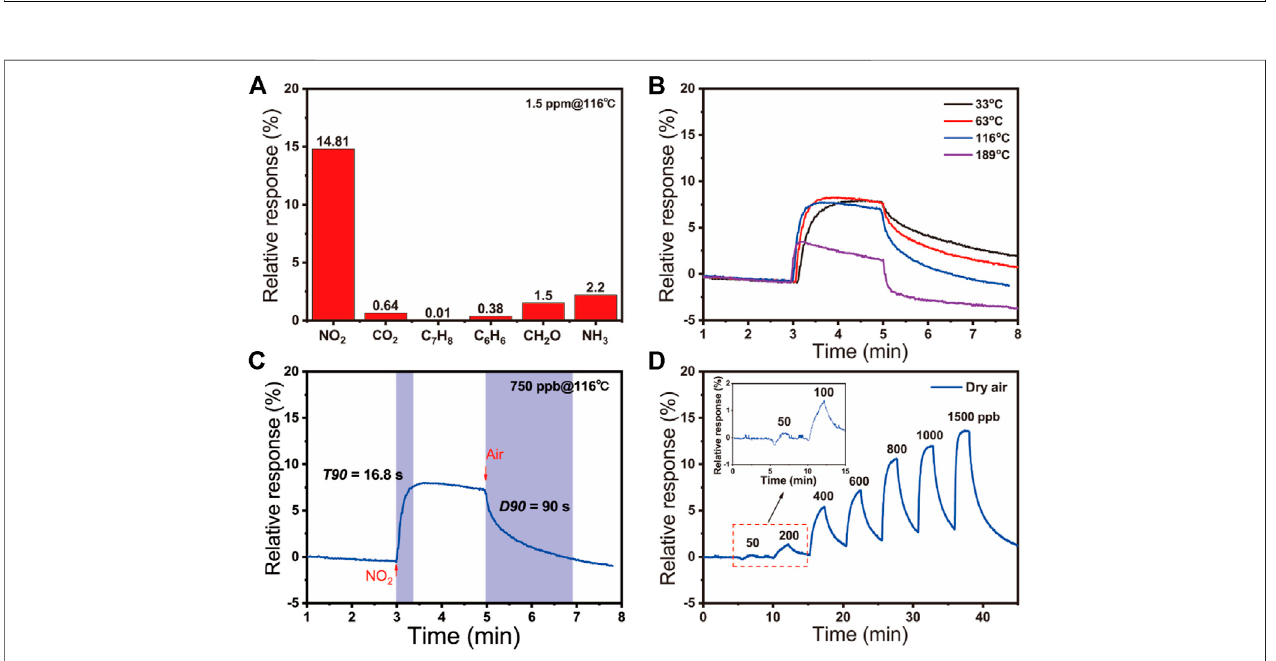
Frontiers in Chemistry |